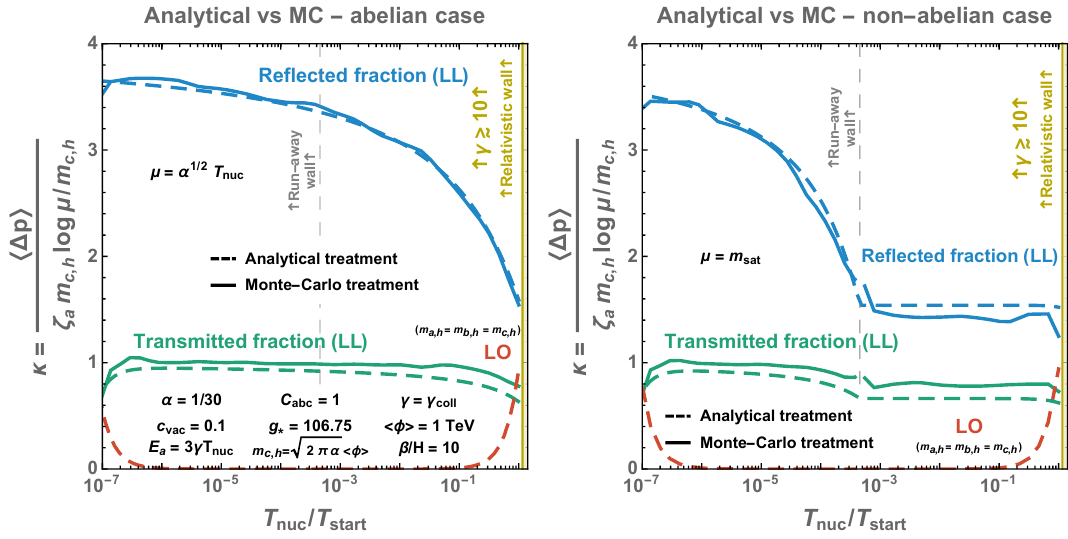
Figure 4 . Average exchanged momentum h ∆ p i = h ∆ p is proportional to γ T 3 h ∆ p i , see eq. (6.4). Dashed lines use the analytical estimate in eq. nuc